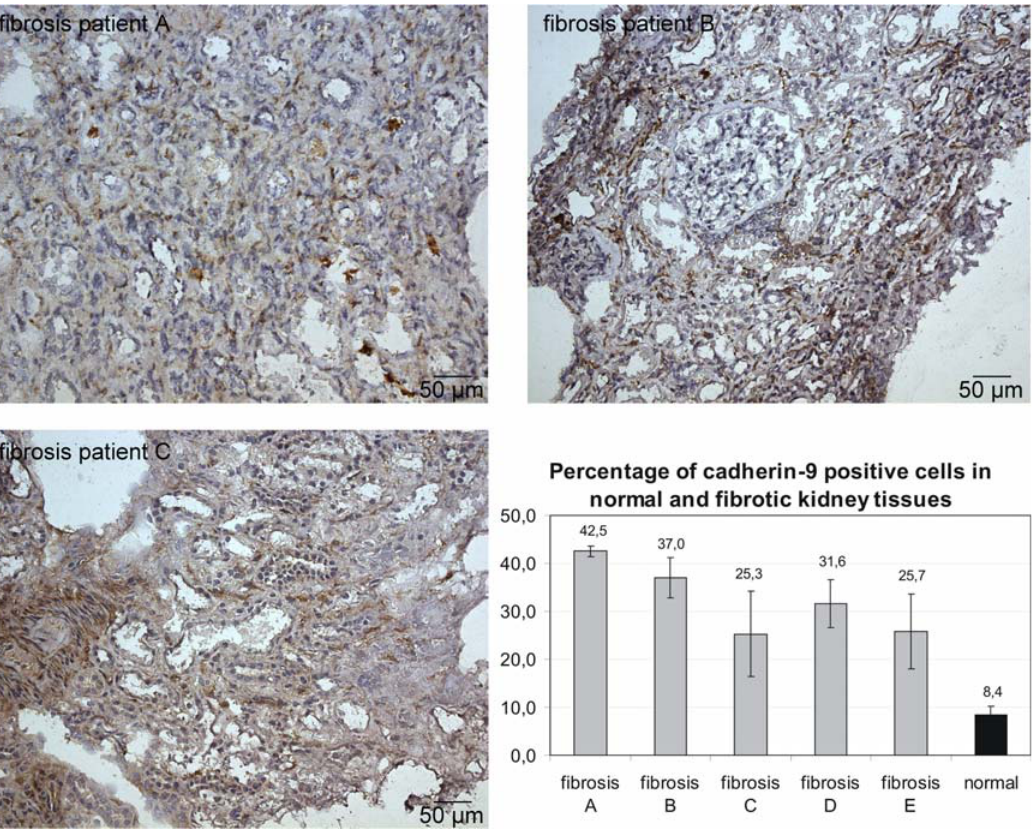
Figure 7. Expression of cadherin-9 in renal fibrosis. Immunohistochemical staining of kidney sections of three fibrosis patients labeled with the cadherin-9 antiserum are shown. The sections were counterstained with hematoxylin-eosin. Cadherin-9-positive cells as well as the total cell number in selected view fields were counted by three independent individuals. Compared to normal kidney sections, a much higher number of cadherin-9 expressing cells could be detected in the fibrotic kidneys. Whereas in normal kidneys only 8.4% 6 1.8 were positive for cadherin-9 expression, the number of cadherin-9-positive cells in fibrotic kidneys was in the range of 25.7% 6 7.8 and 42.5% 6 1.1. Bars, 50 m m.